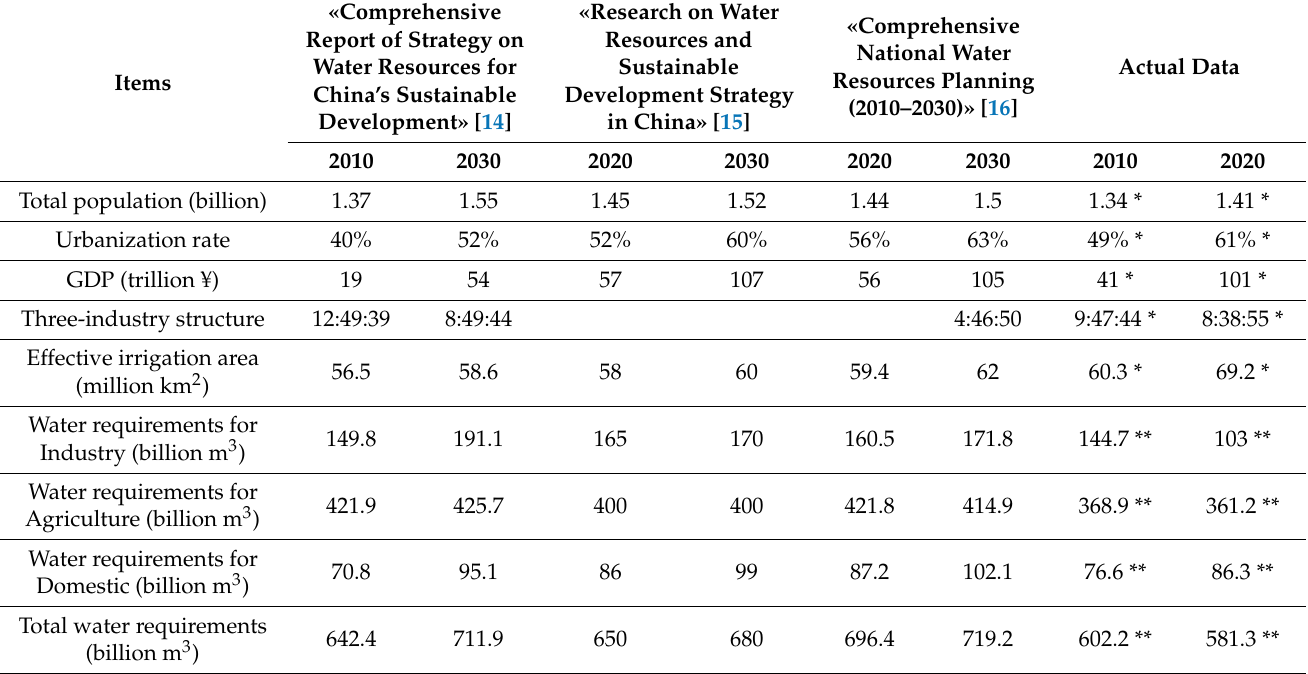
Table 1. Comparison of the predicted data of different research